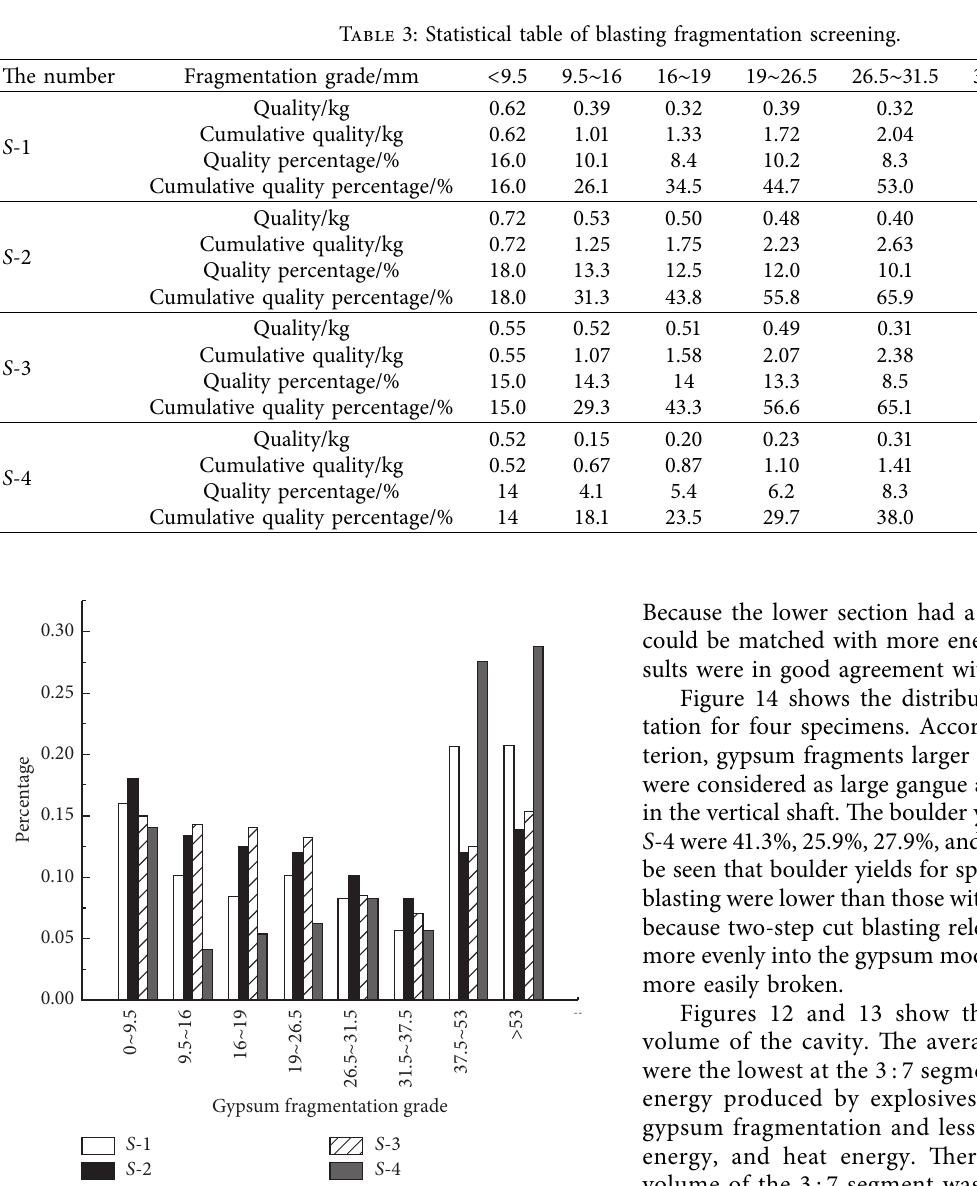
Figure 14: Blast fragmentation grade.